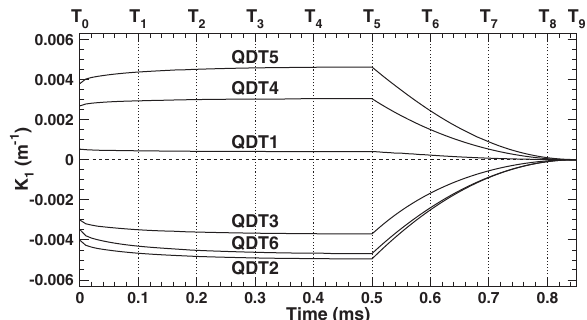
FIG. 4. Time dependence of the horizontal local orbit bump formed for 150 π mm mrad transverse painting, where T n ( n ¼ 0 – 9 ) is defined in Fig. 5.